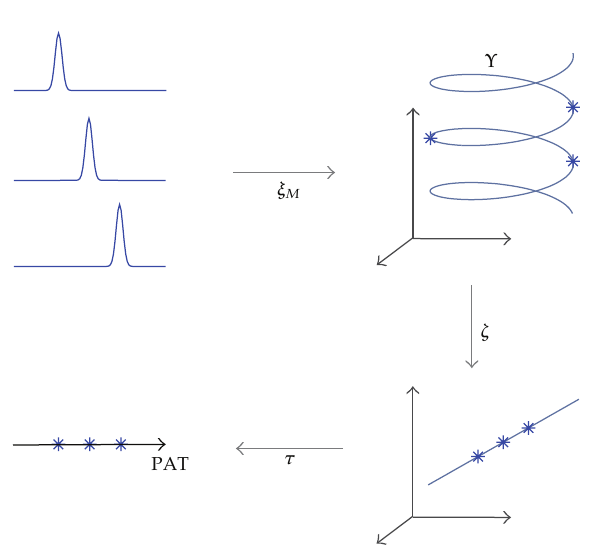
Figure 1: The estimation of PAT using a linear transformation